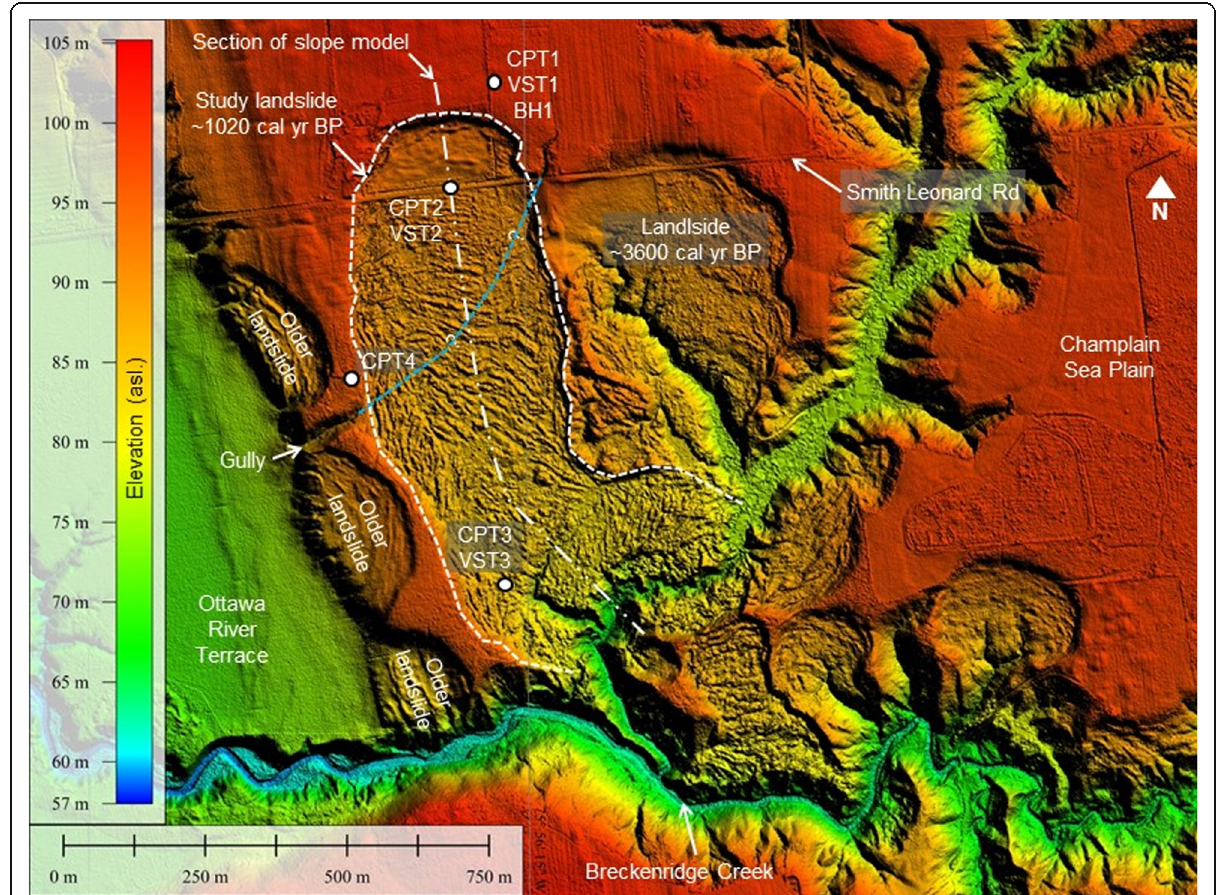
Fig. 2 Breckenridge landslide site (LiDAR image© Government of